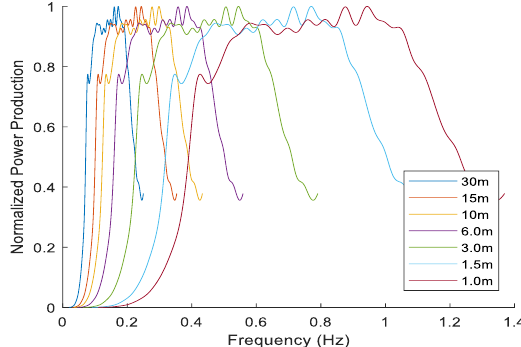
Figure 7: Performance curves for Triton System with varying characteristic